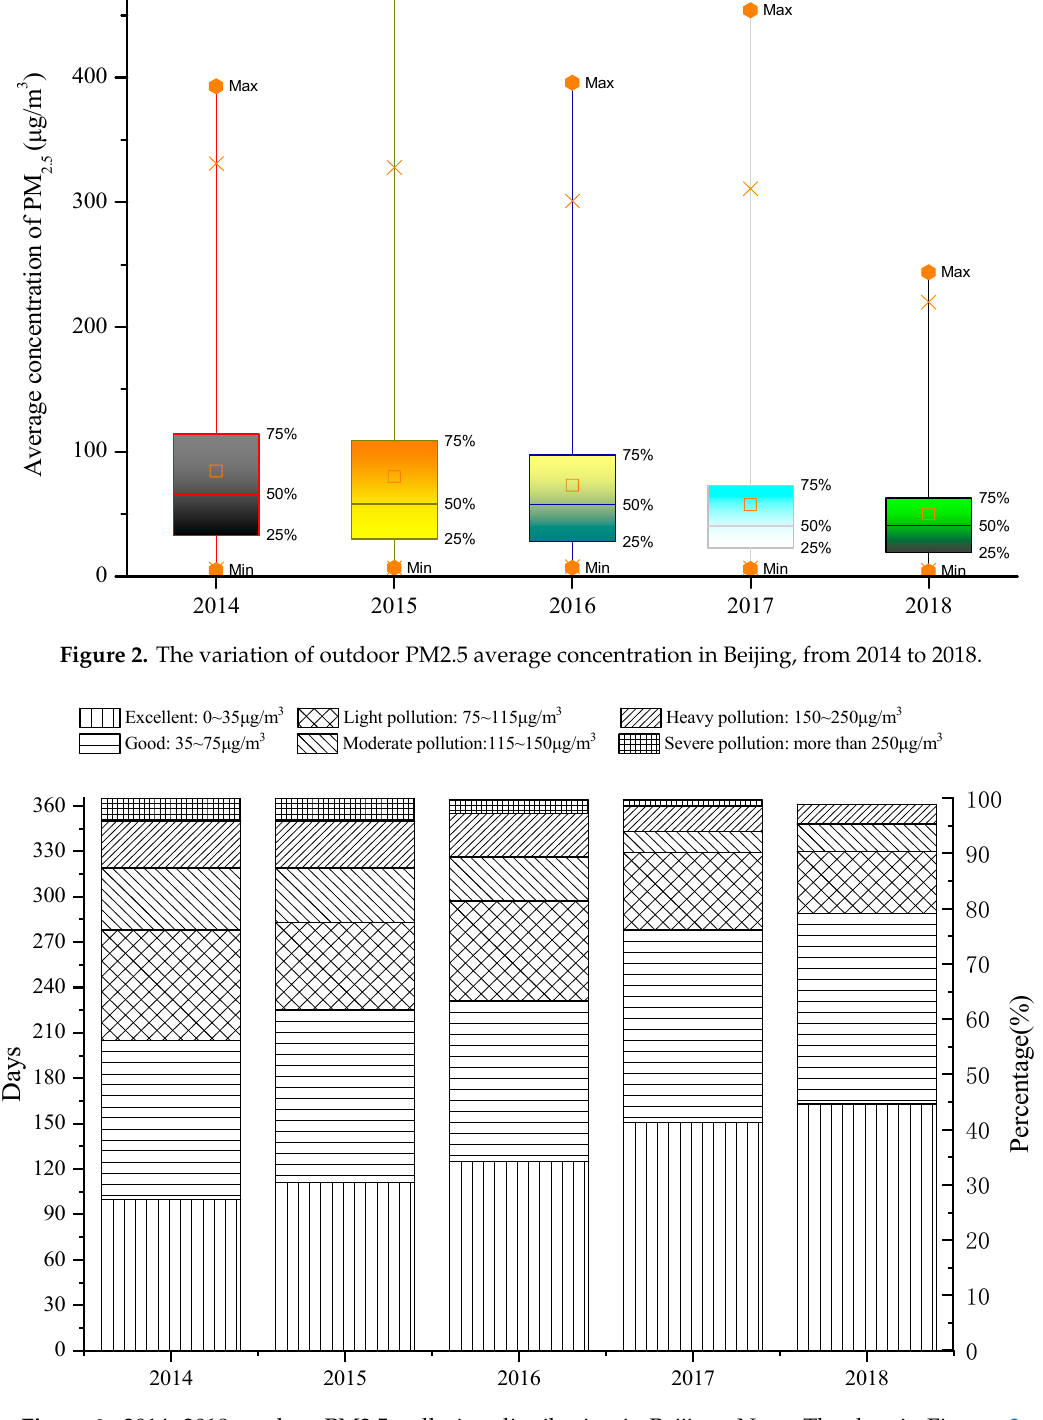
Figure 3. 2014~2018 outdoor PM2.5 pollution distribution in Beijing. Note: The data in Figures 2 and 3 are derived from the China Air Quality Online Monitoring and Analysis Platform. There is no monitoring data on April 16, 2016, September 6, 2016, May 4, 2017, March 28, 2018, and May 5, 26, and 28, 2018, and the corresponding data are not counted.